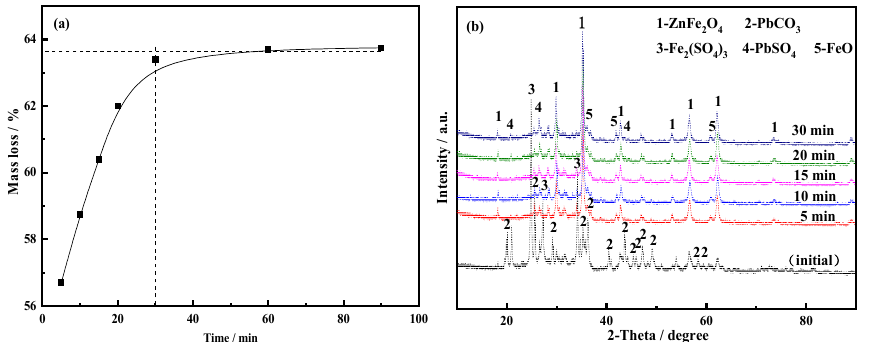
Figure 12. Mass loss and XRD pattern of acetic acid pickling residue at different times; ( a ) mass loss; ( b ) XRD pattern (25 °C, liquid–solid ratio: 10 mL·g − 1 , stirring speed: 400 r·min − 1 , concentration: ( b ) XRD pattern (25 ◦ C, liquid–solid ratio: 10 mL · g − 1 , stirring speed: 400 r · min − 1 , concentration: 3 mol·L − 1 ). 3 mol · L − 1 ).